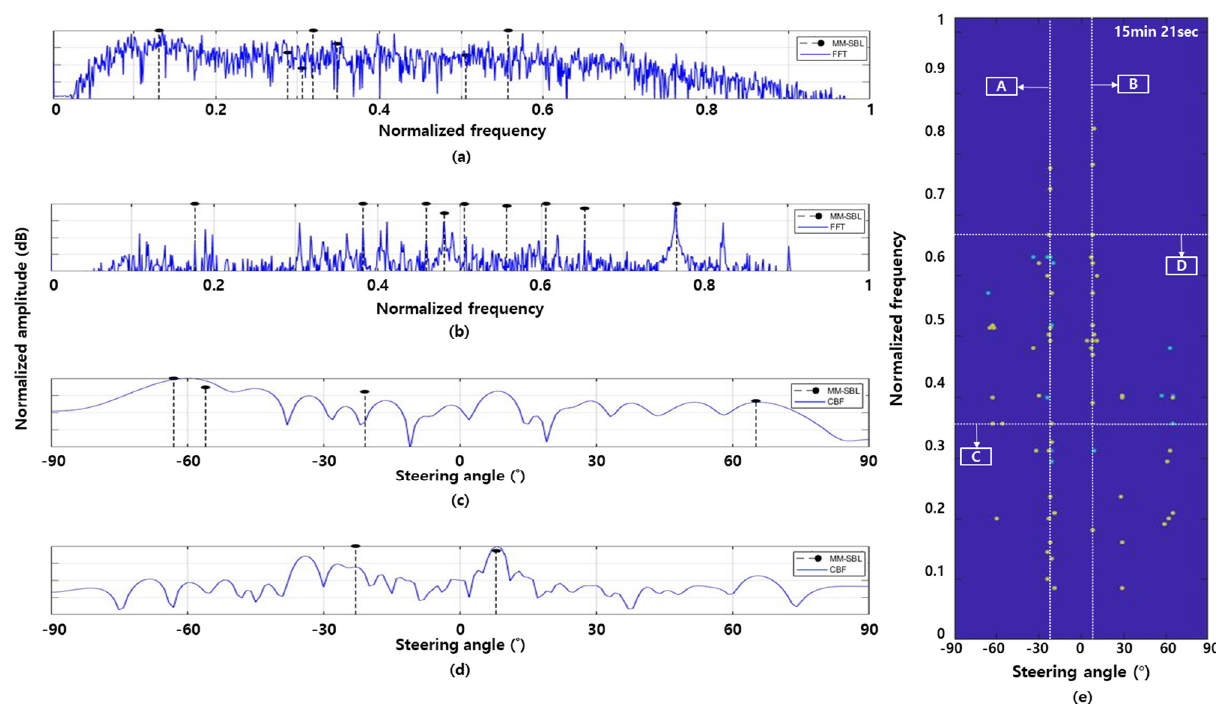
Figure 7. Frequency analysis results at azimuth of ( a ) − 20 ◦ (fishing boat); ( b ) 9 ◦ (experimental ship); and the DOA estimation results at normalized frequency component of ( c ) 0.349 (fishing boat); ( d ) 0.653 (experimental ship); and ( e ) FRAZ plot of the proposed detection method using the MM-SBL at 15 min 21 s. A and B in ( e ) mean frequency lines at steering angle − 20 ◦ and 9 ◦ , respectively. C and D in ( e ) mean azimuth lines at normalized frequency component of 0.349 and 0.653,